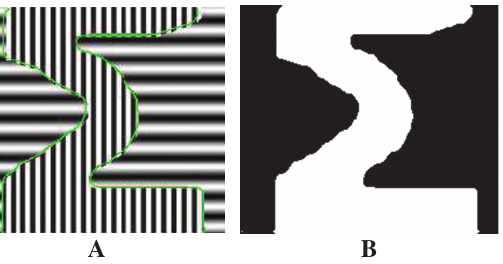
Figure 1. Synthetic Texture Example: (A) Input Image with Superimposed Segmented Bounda- ries. (B) Segmentation Label